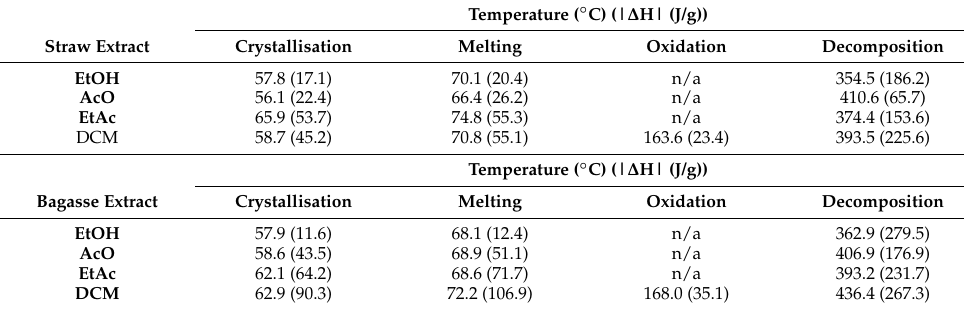
Table 6. Crystallisation, fusion, oxidation and decomposition temperatures ( ◦ C) and enthalpies (J/g) of sugarcane straw and